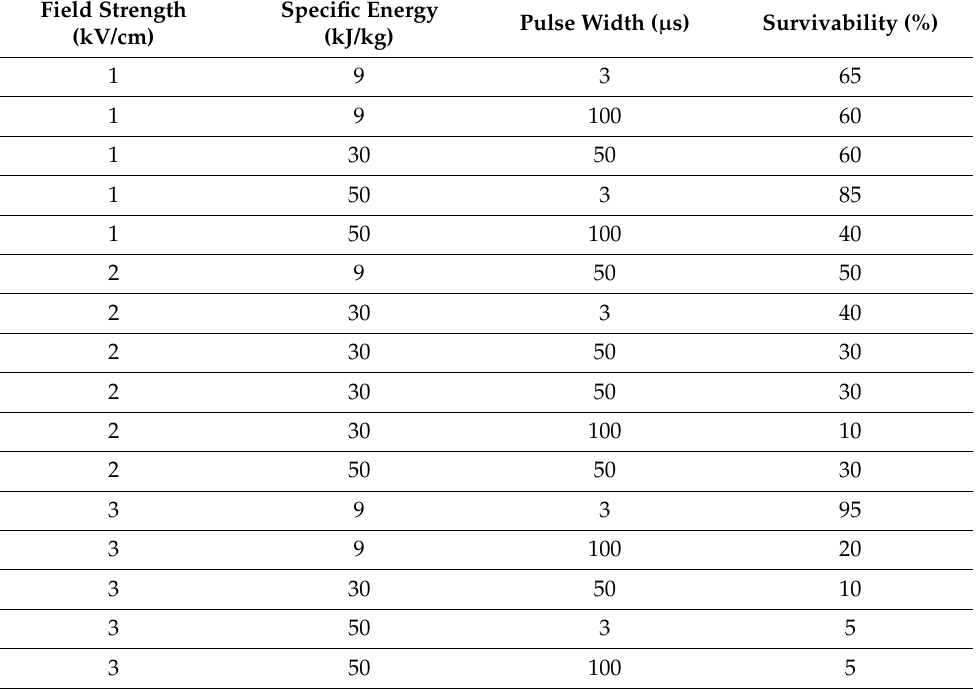
Table 1. Central composite design evaluating the survivability of Anisakis L3 larvae after PEF treatments of varying field strength, pulse width, and specific